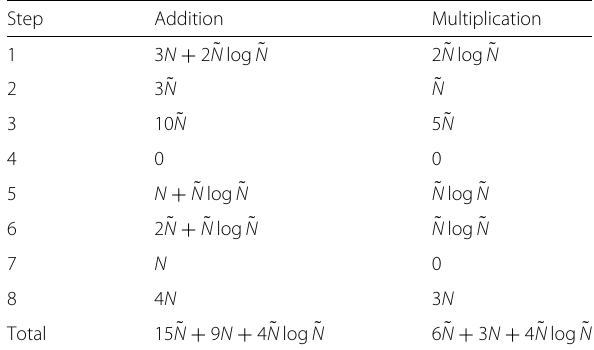
Table 1 The numbers of additions and multiplications for each step in Algorithm 1